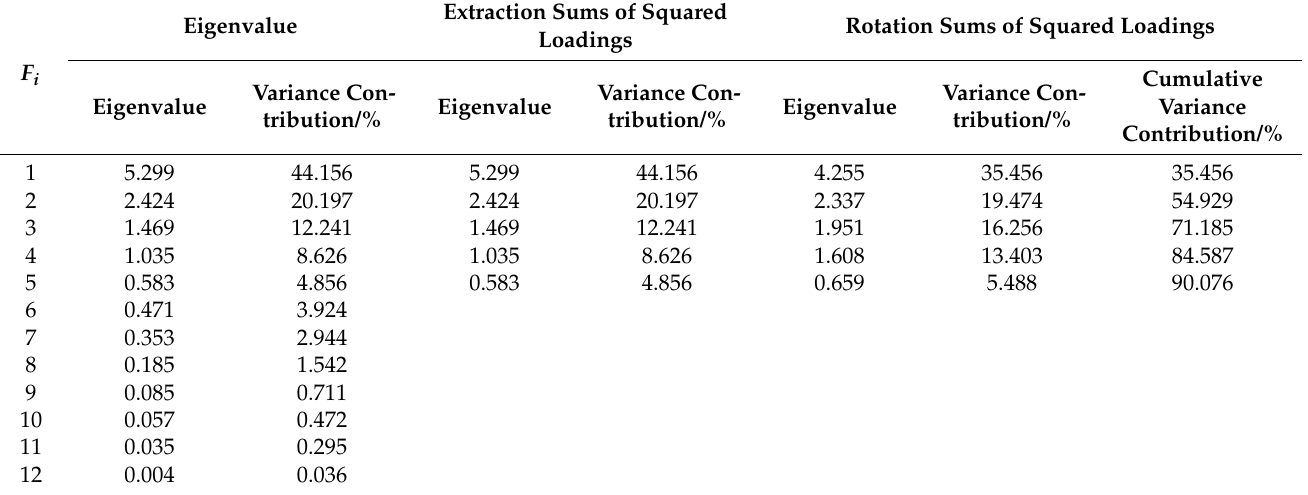
Table 4. The sum of squared loadings and eigenvalues extracted by the principal component analysis.